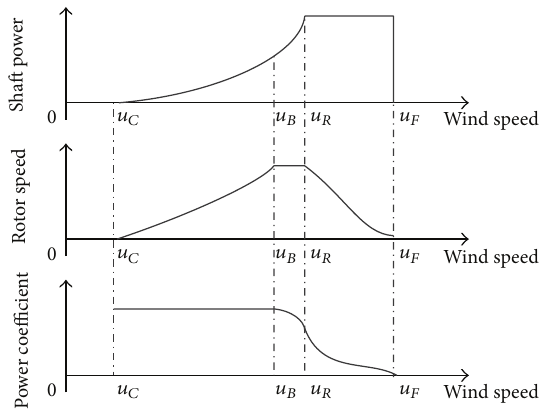
Figure 1: Variable speed operation division of wind